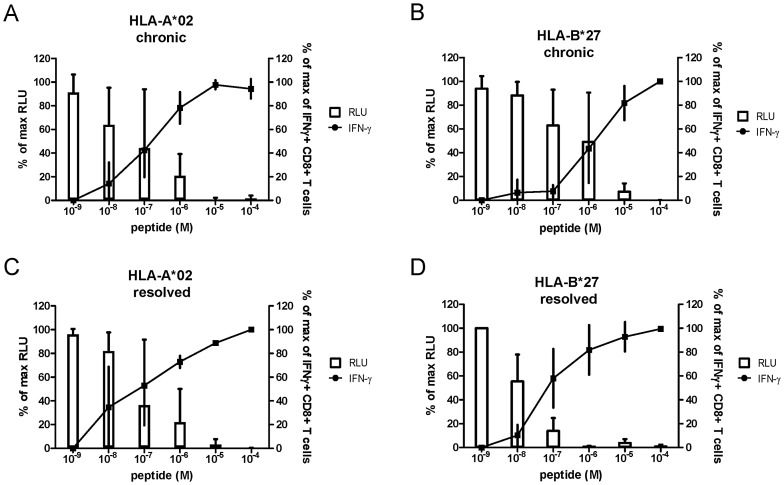
Antiviral efficacy of HCV-specific CD8+ T cells.Antiviral efficacy (white bars) and functional avidity (filled circles) of CTL lines, derived from subjects with a chronic HCV infection specific for (A) HLA-A*02-restricted epitopes (n = 3) and (B) the immunodominant HLA-B*27-restricted epitope NS5B2841 (n = 3) as well as of CTL lines derived from subjects with resolved infection specific for (C) HLA-A*02-restricted epitopes (n = 3) and (D) the immunodominant HLA-B*27-restricted epitope NS5B2841 (n = 3). HuH7A2HCV and HuH7B27HCV cell lines were pulsed with a range of cognate peptide concentrations and cocultured for 24 hours with CTL lines at an E∶T ratio of 1∶1. Inhibition of viral replication was measured by luciferase activity. As a reference, intracellular IFN-γ staining at corresponding peptide concentrations is indicated. Measured RLUs and IFN-γ responses were normalized to maximum viral replication or maximum IFN-γ response, respectively, by defining the smallest value as 0% and the largest value as 100%. Data are presented as mean ± SD.